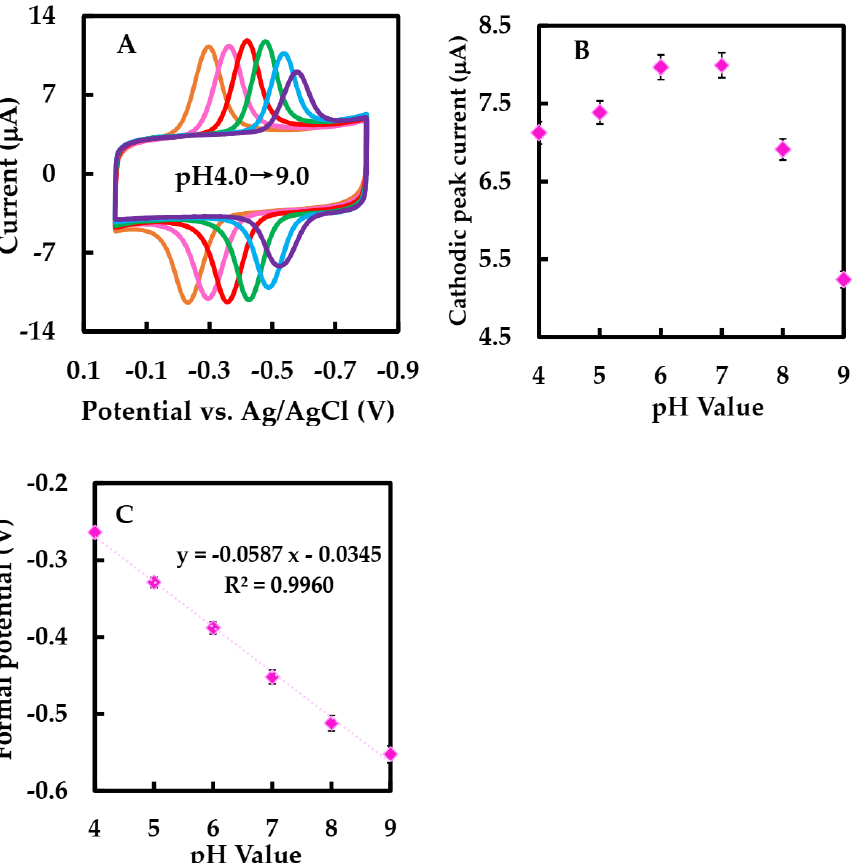
Figure 5. ( A ) CVs of the NF-GLA/MWCNTs-BSA-HFs-GOD/GCE in N 2 -saturated 50 mM phos- phate-buffered solution (pH 6) at different scan rates (from inner to outer): 0.01, 0.02, 0.03, … 1.8, 2 V ‧ s −1 , respectively. ( B ) The relationship of the scan rates (0.03 – 0.4 V ‧ s −1 ) versus the peak currents. ( C ) The relationship of the peak potential ( Ep ) versus ln v .